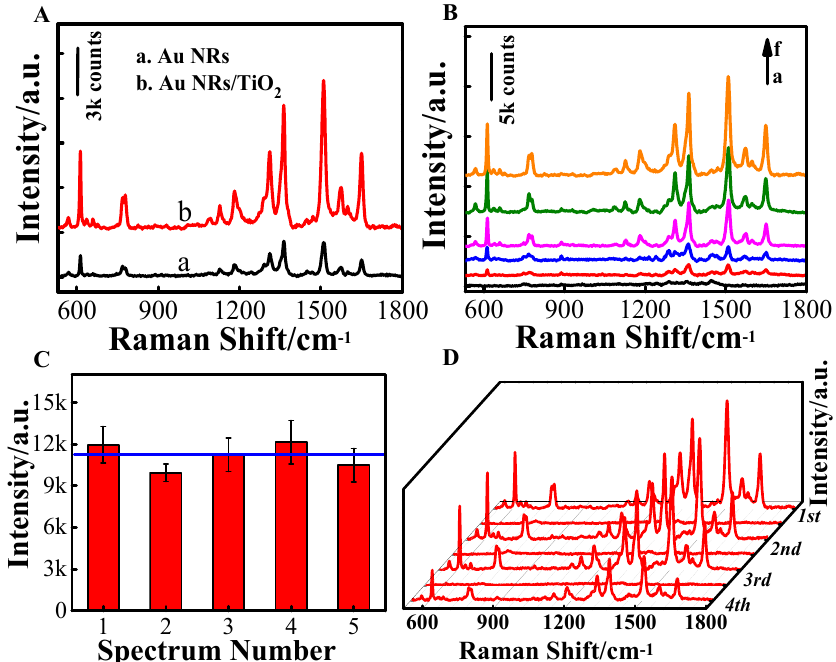
Figure 3. ( A ) The SERS signals of 0.1 µ M R6G on the Au NRs@TiO 2 substrates were compared with those on the Au NRs substrates; ( B ) SERS spectra of R6G with different concentrations